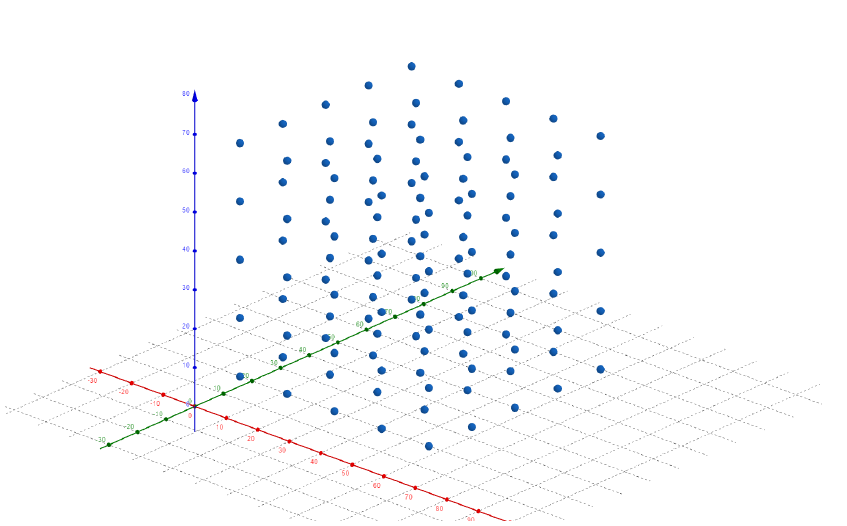
Figure 14. 75 m × 75 m × 75 m 125 nodes grid